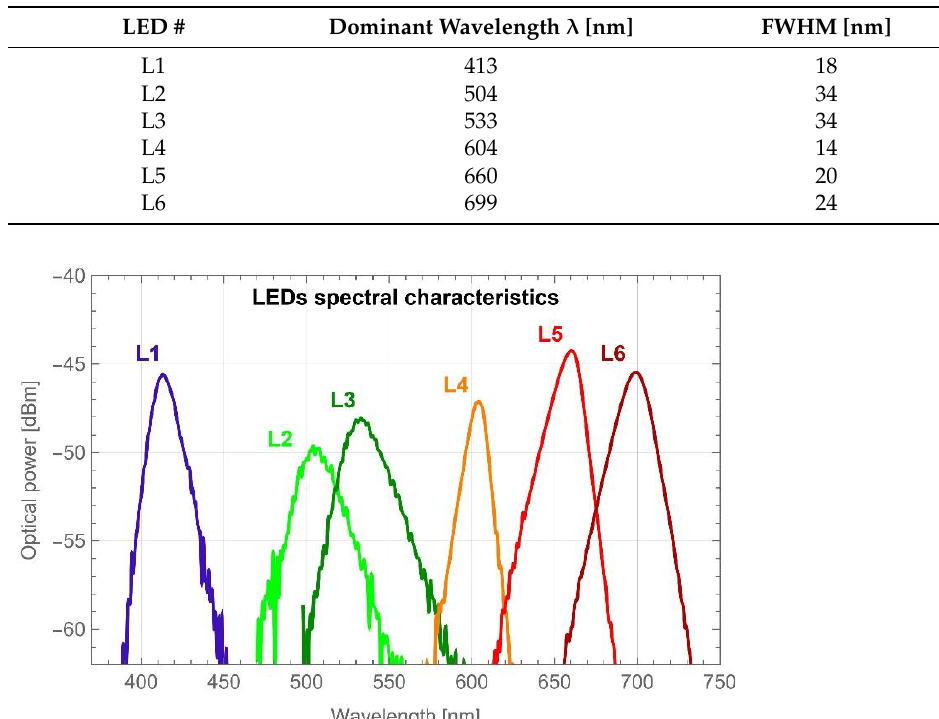
Table 1. Dominant wavelengths and FWHMs of the LEDs used in the portable multispectral fibre- optic reflectometer.